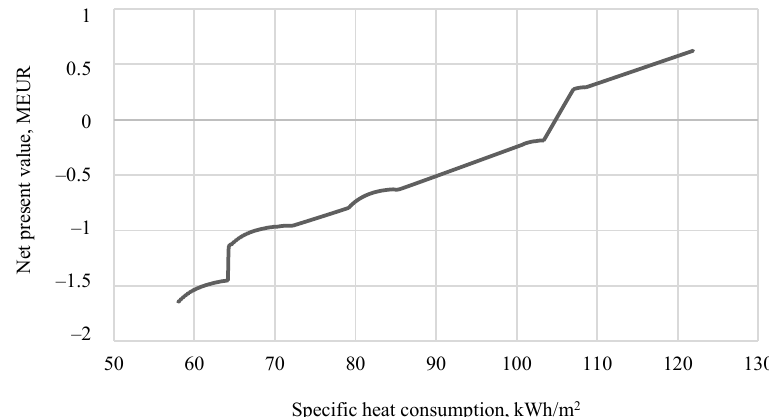
Fig. 3. Pareto-optimal solutions in terms of net present value and specific heat